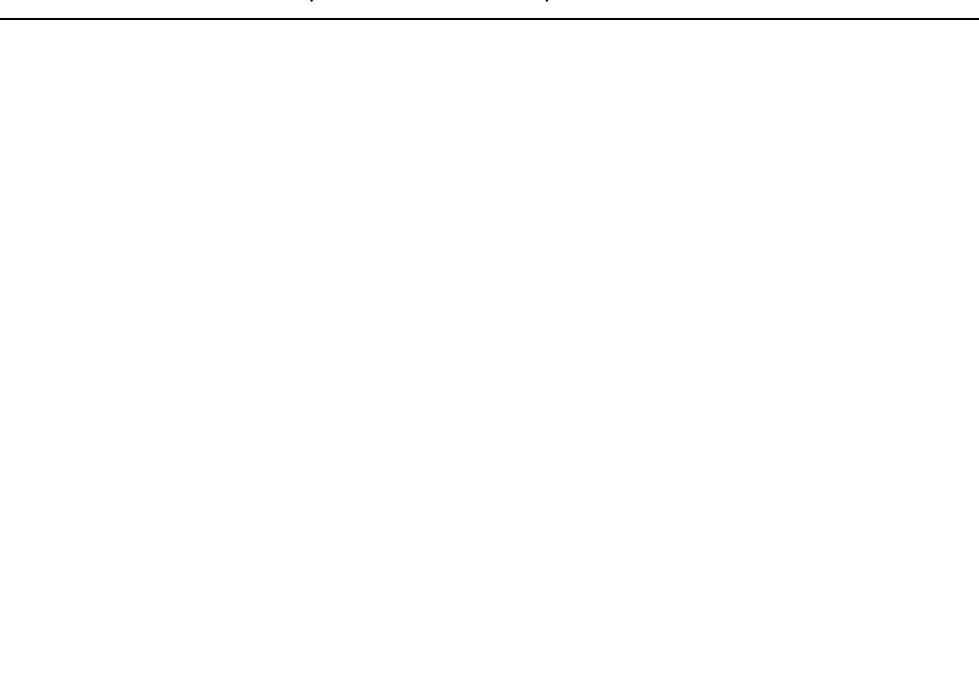
environments or during intensive physical activities. Lastly, grade 4 is applied when abundant sweating occurs even in mild climates or environments with normal humidity levels or without physical activity, bothering the patient and causing their clothes to get wet so that they need to change them during the day. The patients graded dryness following the scale proposed by Lee et al. 2004 48 as 1-excessive dry hand, 2-dry hands, and 3-the same hand sweating as before the operation. Overall patient satisfaction was measured using a five-point scale with the following grading: very unhappy, unhappy, dissatisfied, not completely happy, or very happy. Quality of Life Questionnaire 40 , values over 84 indicated a pretty poor quality of life, low from 69 to 84, proper from 36 to 51, and excellent from 20 to 35. Primary and secondary endpoints. The primary endpoint was the prospective objective evaluation of CH’s incidence and severity in treating primary hyperhidrosis patients with T 3 –T 4 SY versus T 3 –T 4 RC in age- and sex-matched controls. In addition, we will present the results as the rate of symptom resolution and the degree of postoperative patient satisfaction. The secondary endpoints evaluated the incidence of dry hands, gustatory sweating, complication rate, hospital stay, and recurrences of T 3 –T 4 SY versus T 3 –T 4